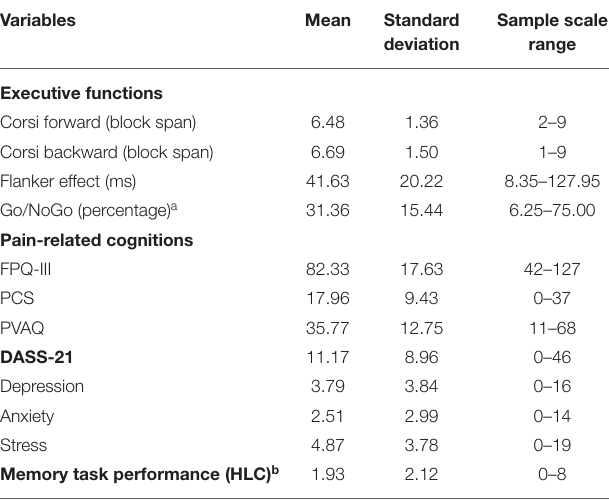
TABLE 1 | Psychometric characteristics of the sample.